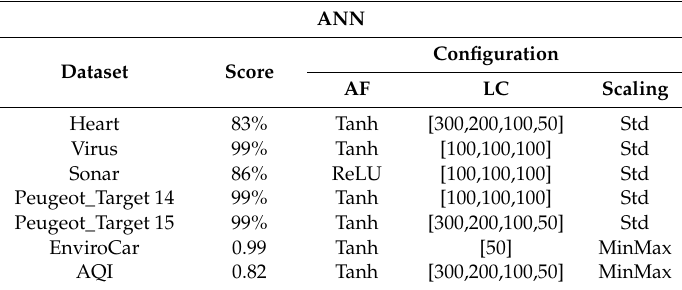
Table 23. ANN performance and configuration for PCA =